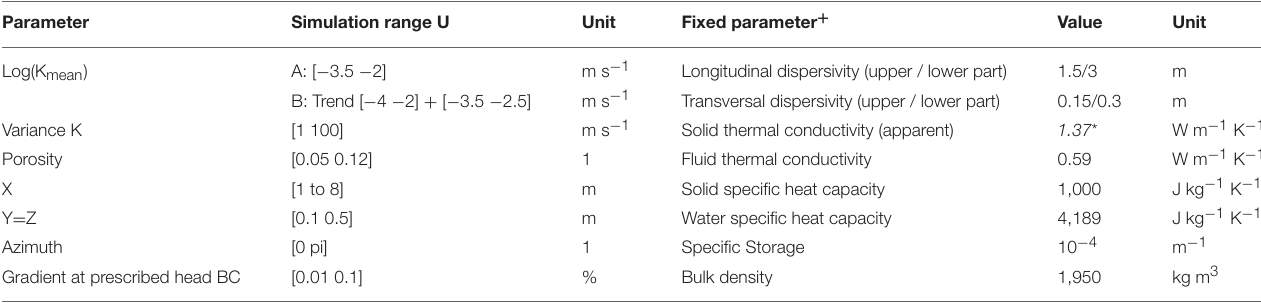
TABLE 1 | Parameter simulation ranges for the Monte-Carlo simulations (left column) and chosen fixed parameter values identical to those chosen by Klepikova et al. (2016) (right column).